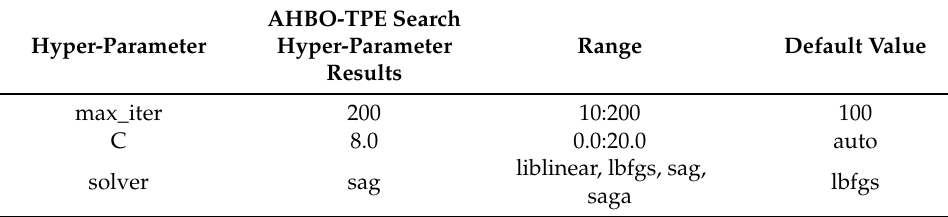
Table 11. LR Model AHBO-TPE Search Hyper-parameter Results (Ember Dataset).